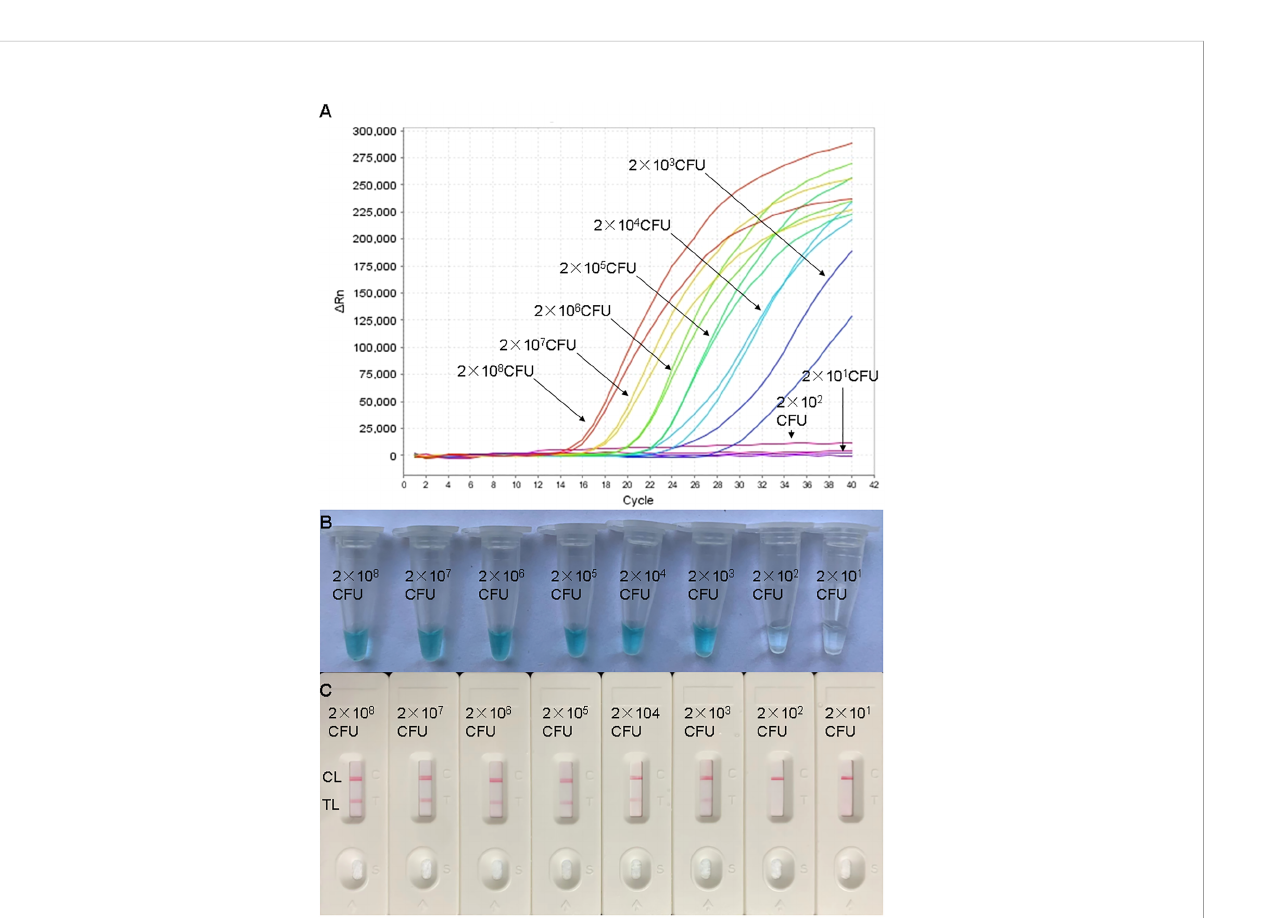
FIGURE 4 Sensitivity con fi rmation of H. in fl uenzae-real-time MCDA assay. Sensitivity of the H. in fl uenzae-real-time MCDA assay was analyzed by using continuous dilutions from 2×10 8 to 2×10 1 CFU/ml. The real-time MCDA reactions with various levels of DNA templates were repeatedly tested twice. Signals (A) representing DNA levels showed that the LoD of the H. in fl uenzae-real-time MCDA was 10 CFU per tube. The sensitivity was also con fi rmed with indication of visual detection reagent (B) and LFB test (C) for the production of MCDA reactions. (C) TL, test line; CL, control